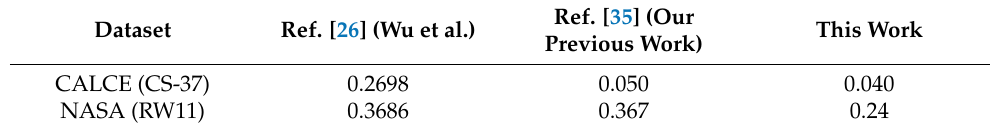
Table 3. Comparison of RMSE values of the proposed method with Refs. [26,35].